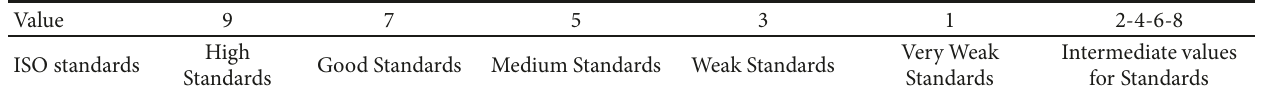
Table 2: 9-point Likert spectrum for